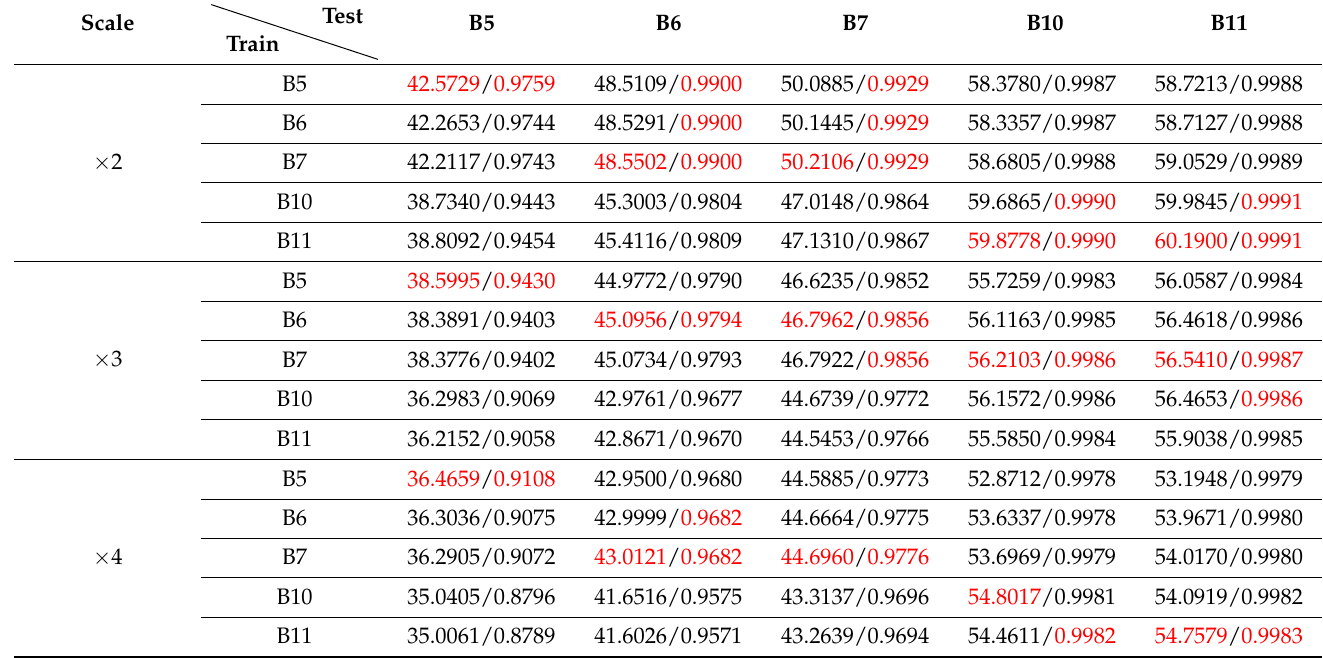
Table 9. Results of spectrum adaptability for supervised learning (PSNR(dB)/SSIM). The best results of every spectrum are marked in red.